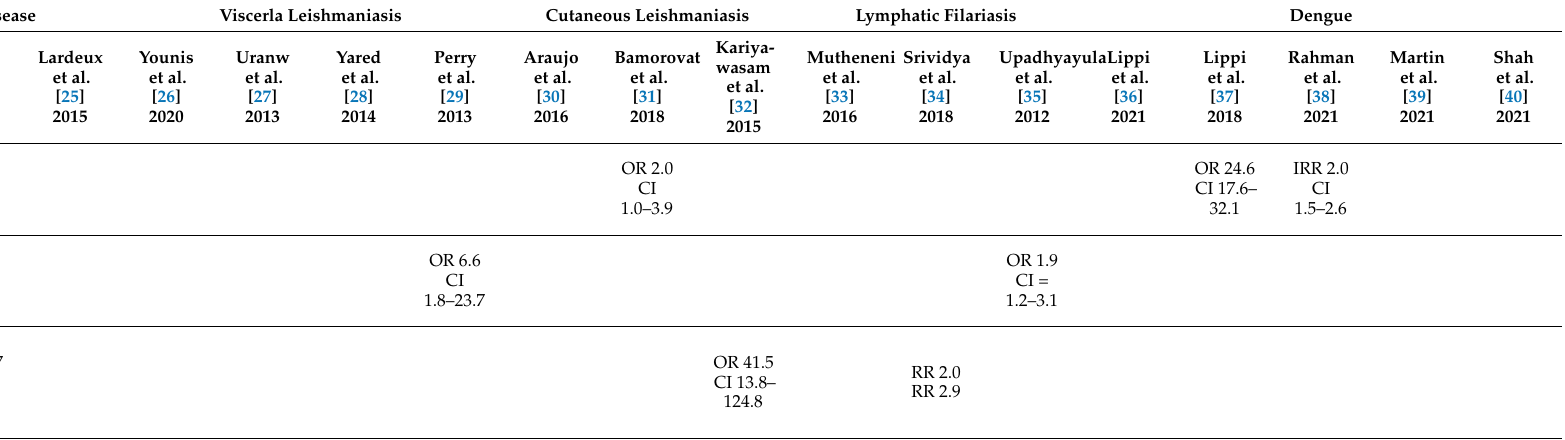
Table 1. Housing conditions as risk/protective factors for the considered NTDs (OR-odds ratio; AOR-adjusted odds ratio; CI-confidence interval at 95%; RR-relative risk; IRR-incidence rate ratio; p - p value). Chagas Disease Viscerla Leishmaniasis Cutaneous Leishmaniasis Lymphatic Filariasis